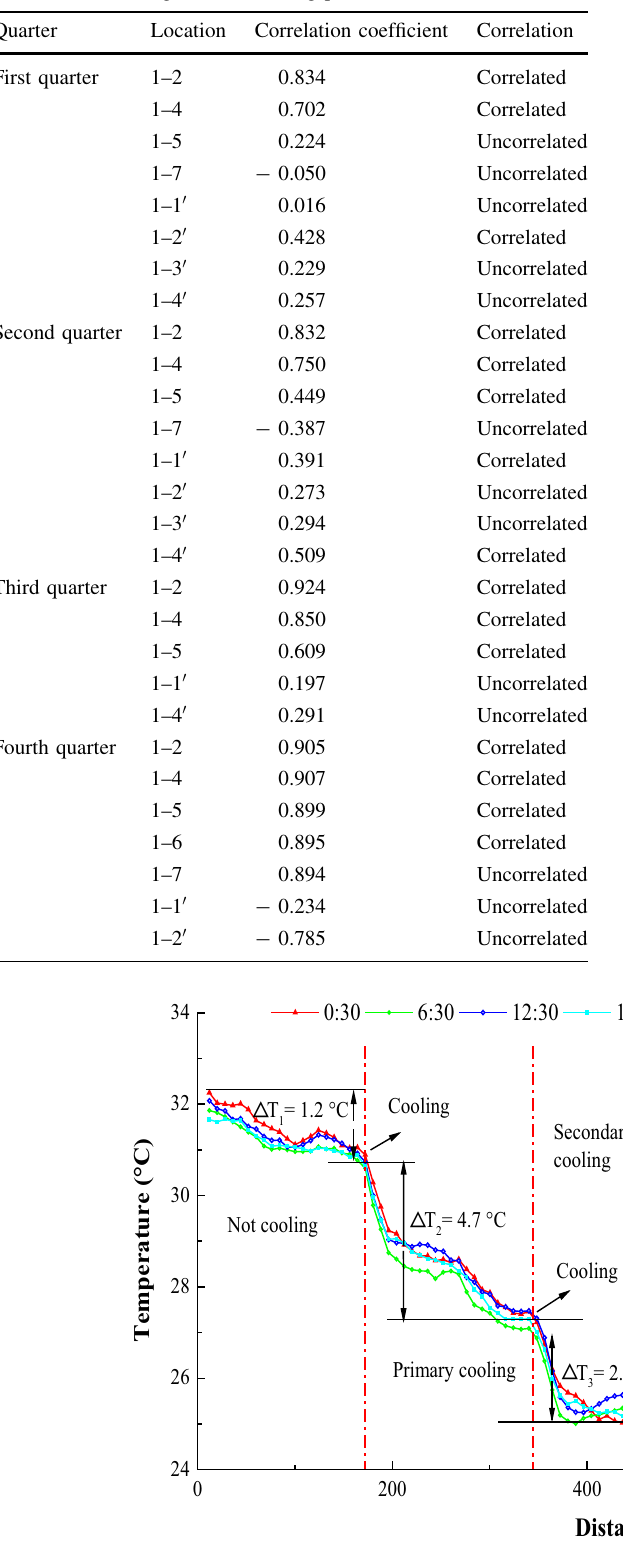
Table 4 Correlations between surface temperature changes at the wellhead and underground measuring points